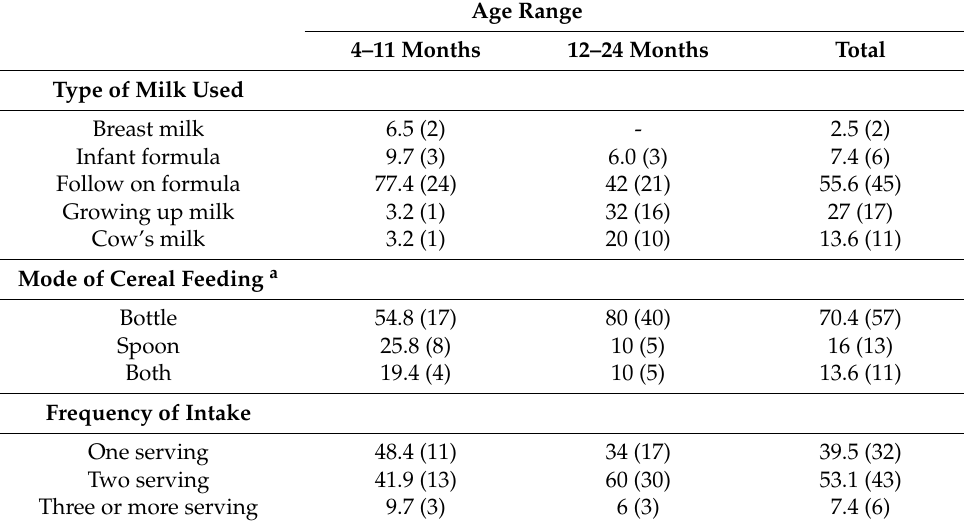
Table 3. Cereal feeding practices used for parents to prepare the infant